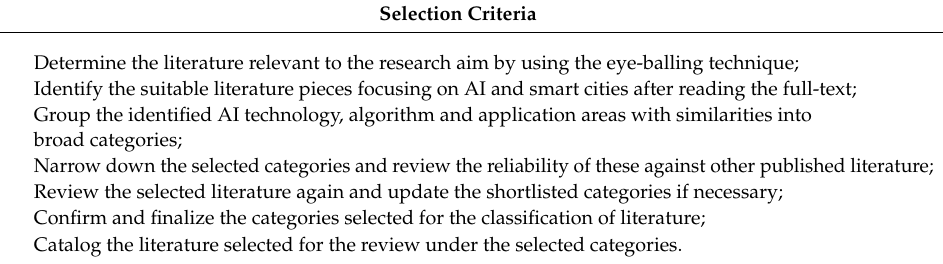
Table 1. Selection criteria for formulating categories.